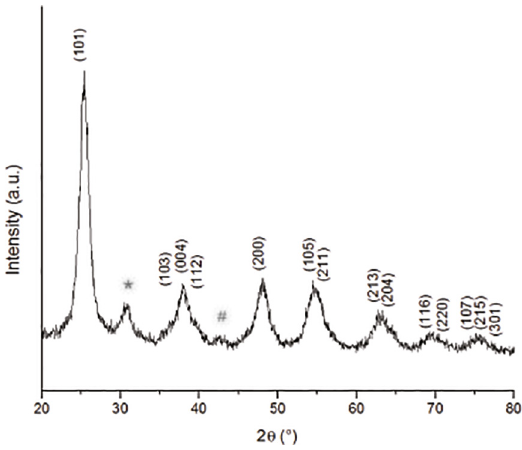
nanoparticles synthesized 2